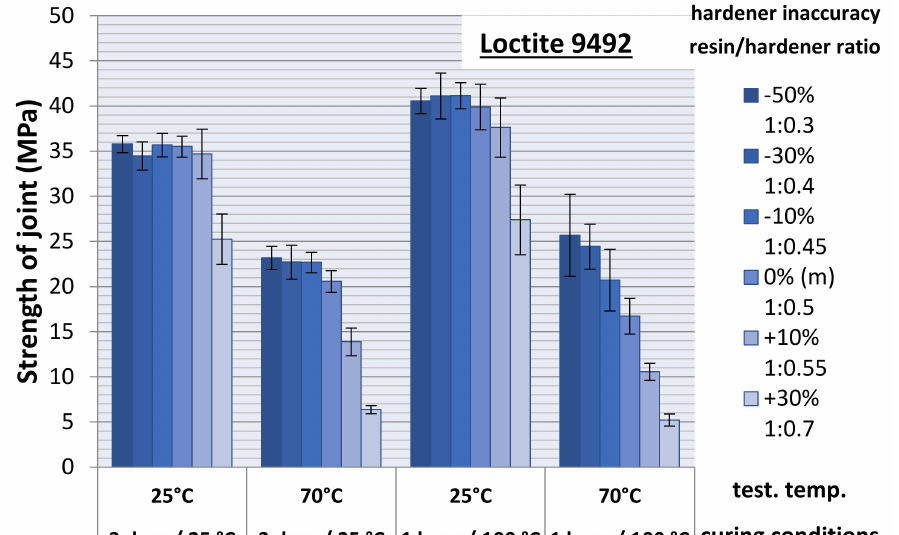
Figure 9. Summary of the strength test